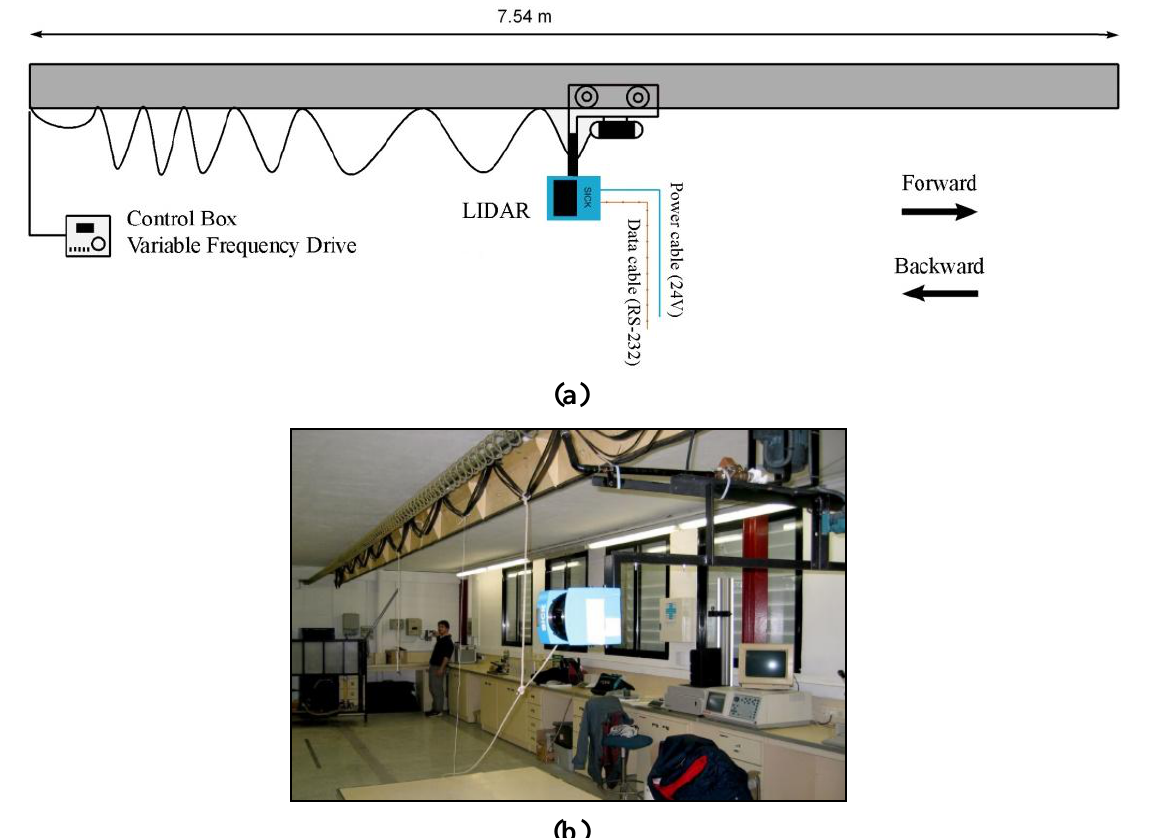
Figure 4. (a) Assembly layout of the LMS200 sensor on the motorised rail. (b) Photograph of the test